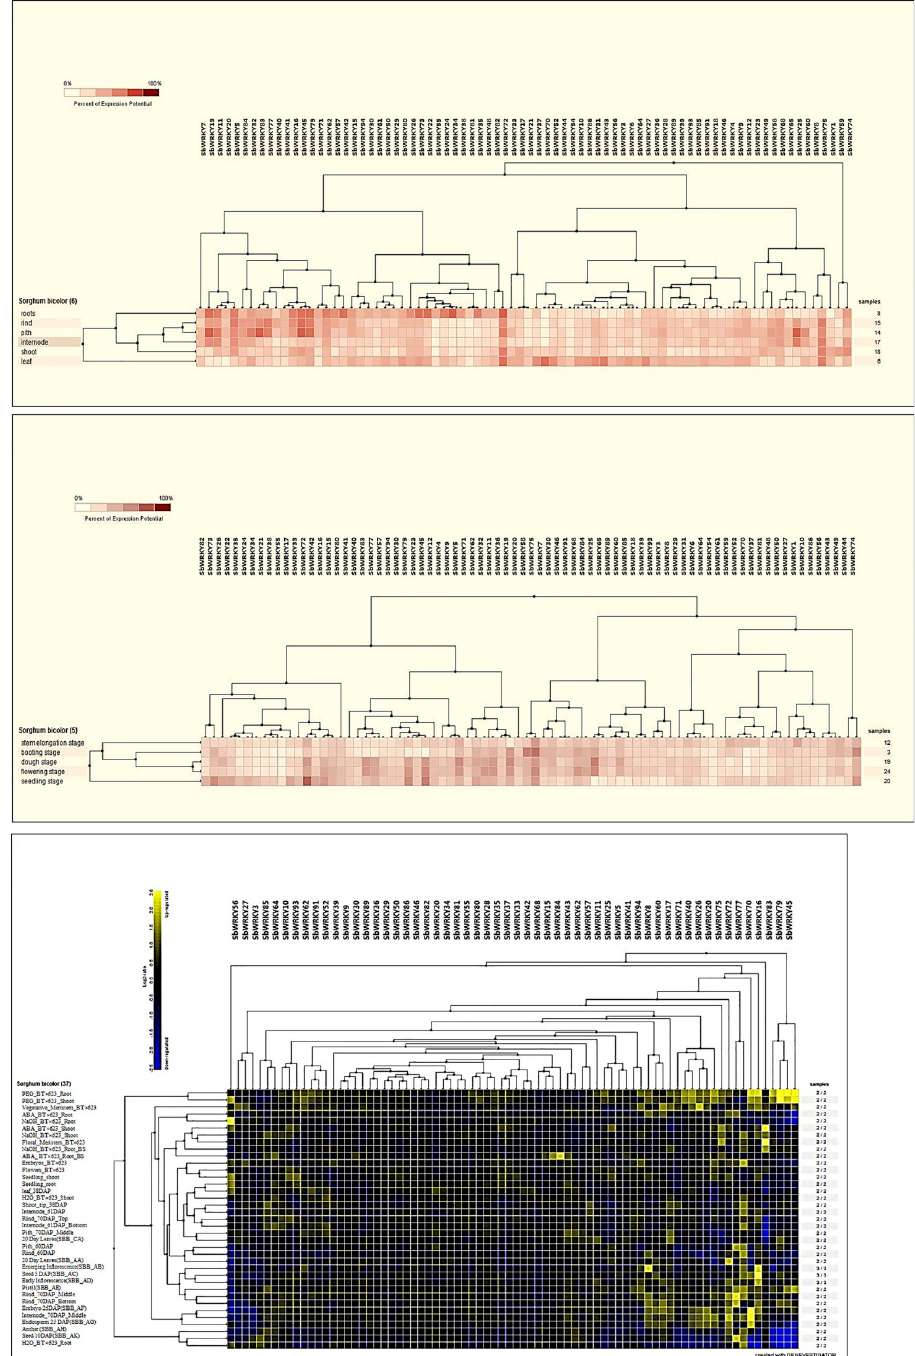
Fig 6. Heatmaps of SbWRKY gene expression. SbWRKY expression levels in different tissues (a) and at different growth stages (b). (c) Hierarchical clustering of SWRKY gene expression patterns under different environmental conditions, including drought, ABA, heat, salt and combination